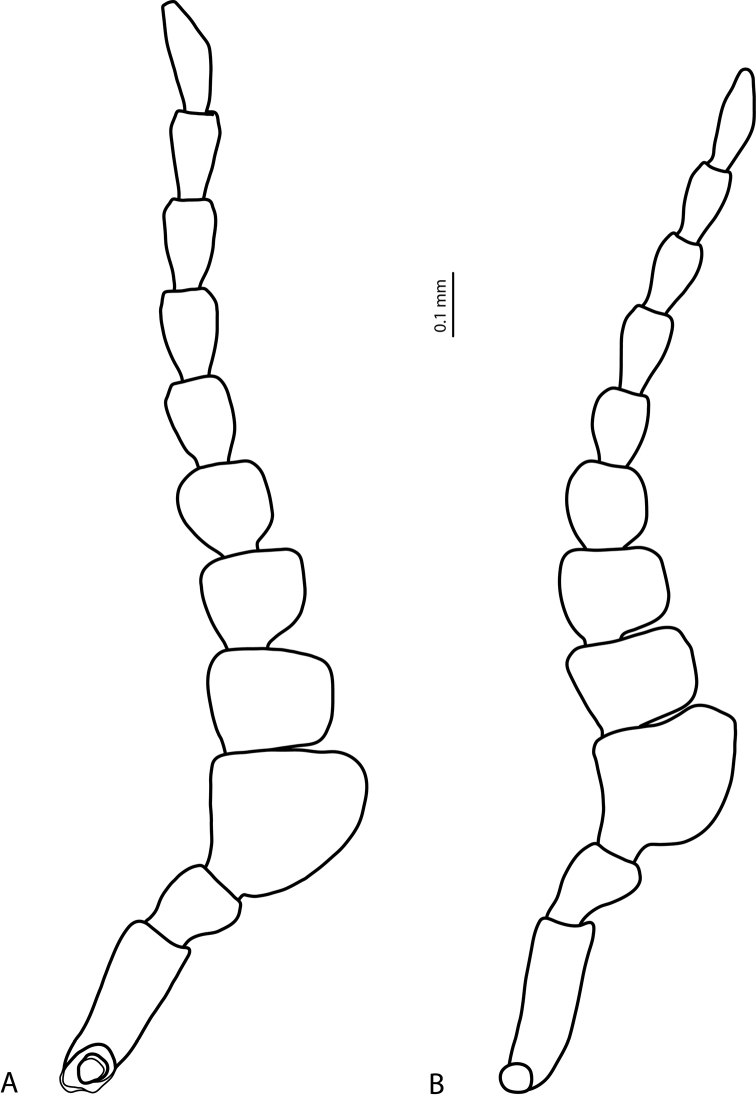
Male antennae AExocelina
athesphatos sp. nov., paratype BE.
tsinga sp. nov., paratype.